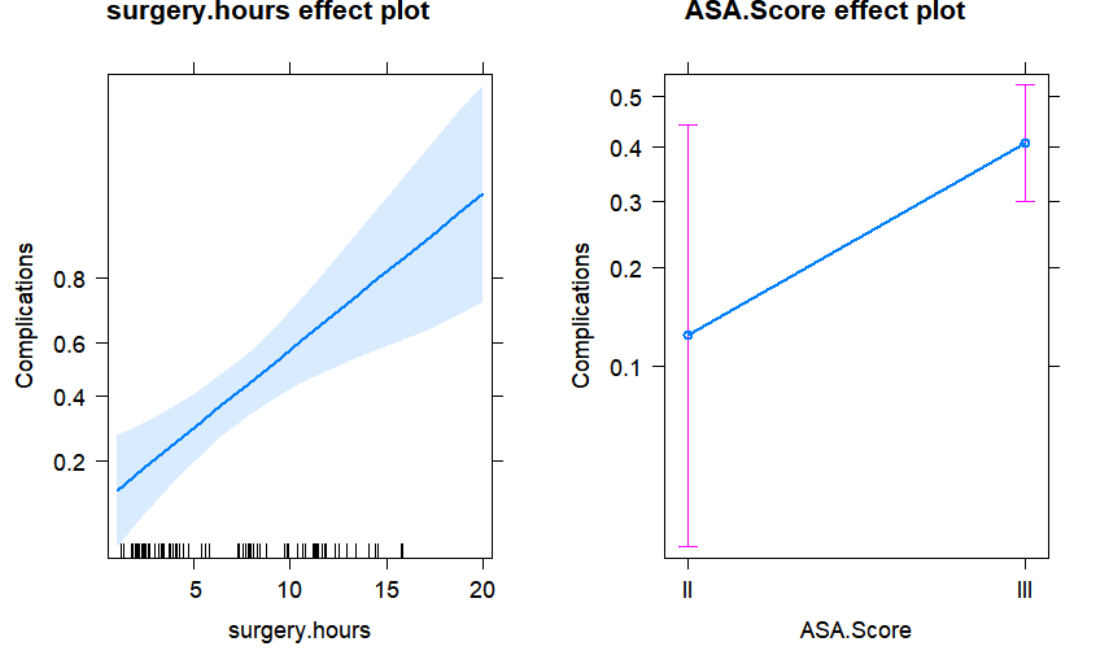
Figure 1. Effect plots for the surgery hours and ASA score from the final logistic regression model for the risk of complications.